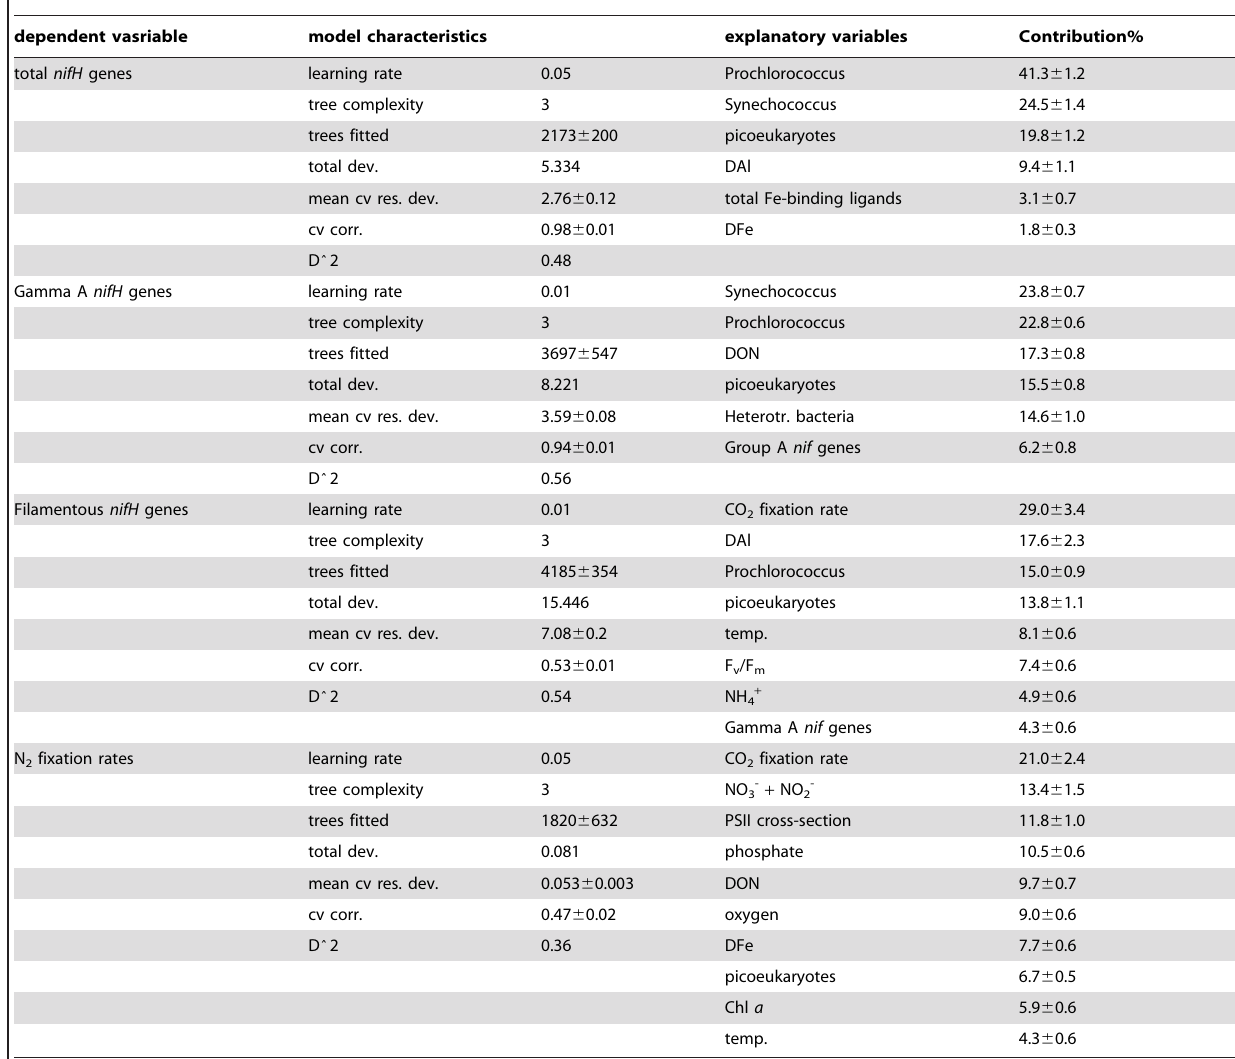
Table 1. Mean predictive performance of the BRT models and contributions of explanatory variables to the prediction of the N 2 fixation rates, the total concentration of nifH genes, the concentration of nifH genes of filamentous cyanobacteria and Gamma A, a